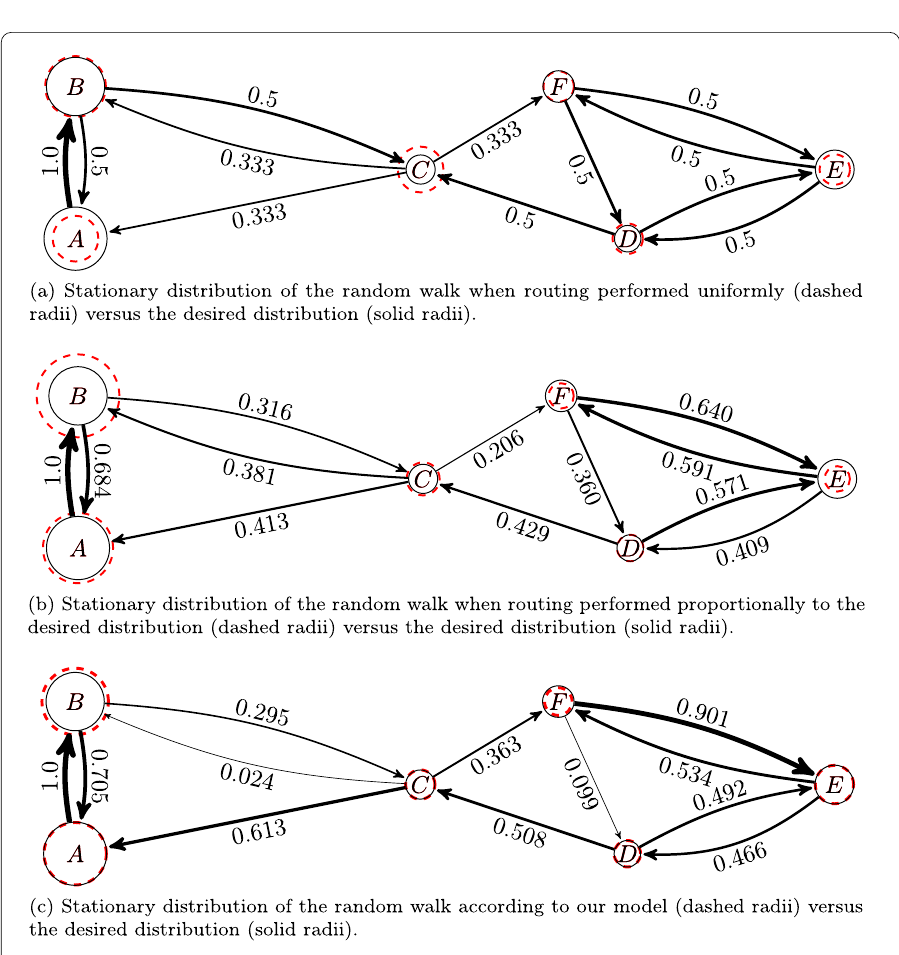
Figure 1 Illustration of the problem of finding transition probabilities for some desired stationary distribution. The radii of the nodes is proportional to their share from the stationary